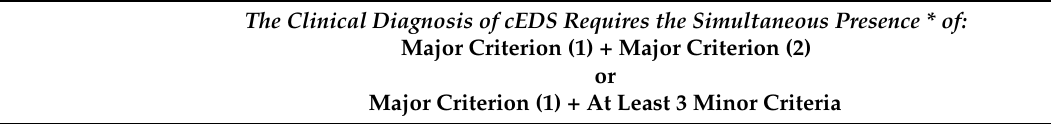
Table 1. Clinical diagnosis of Classical